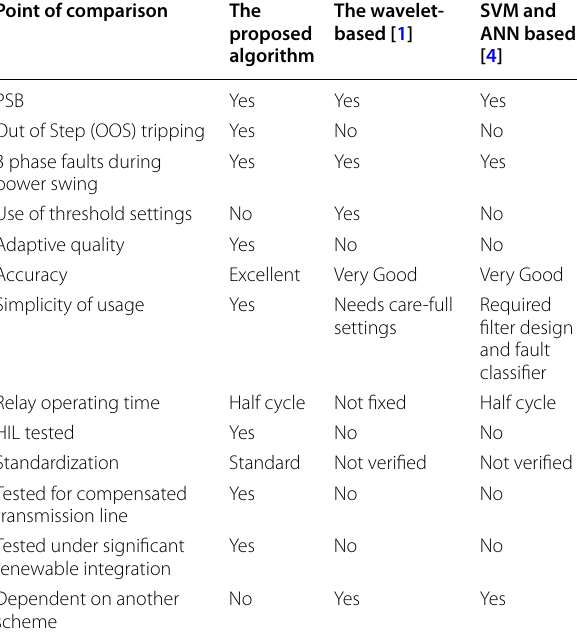
Fig.12 Diagram of the 29-bus, 7-power plant network system (Hydro-Quebec)